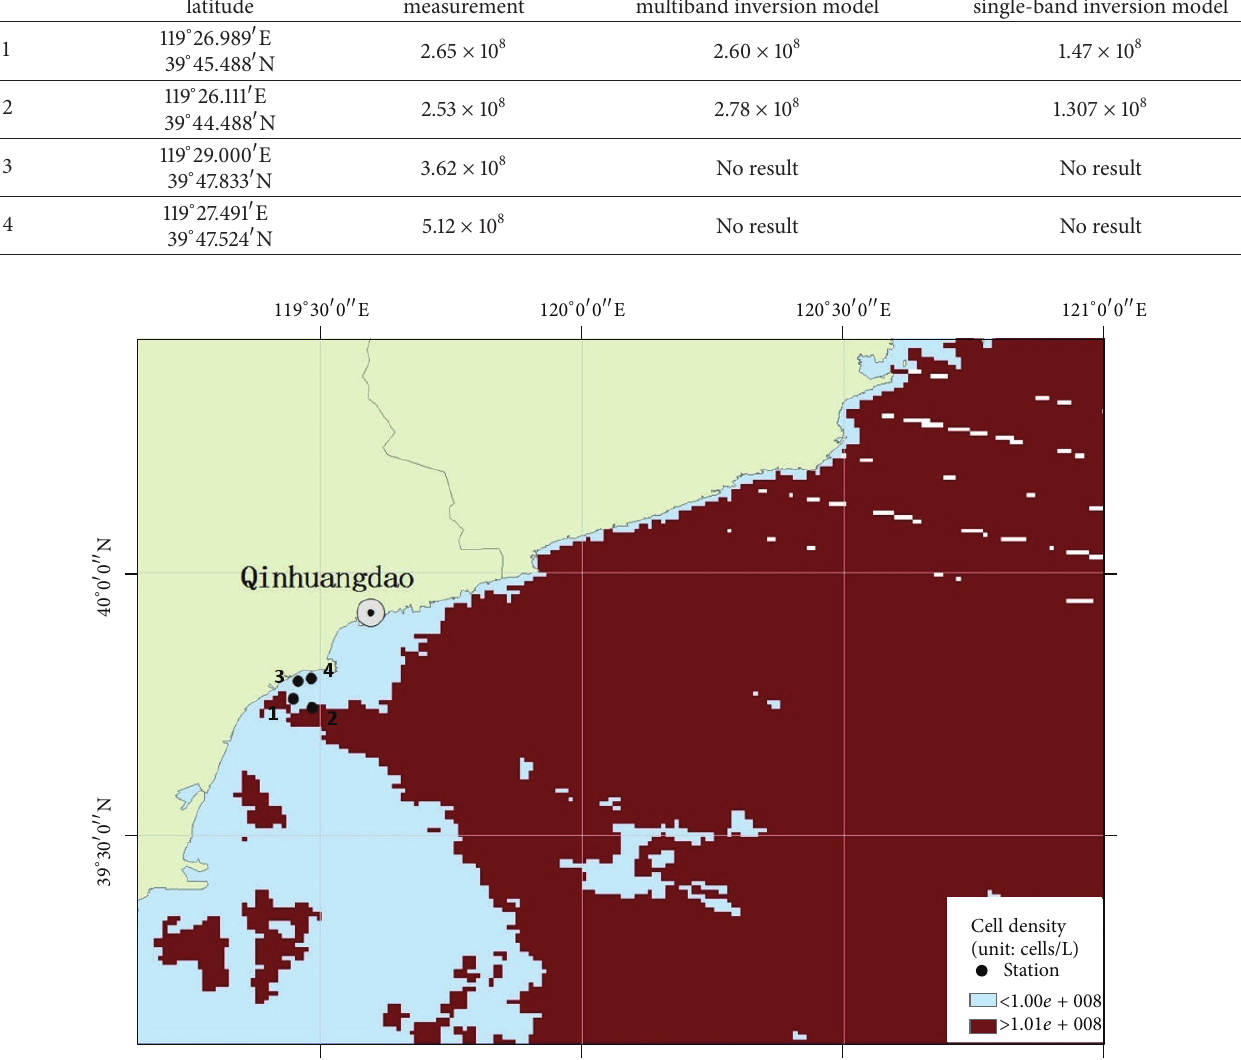
Figure 7: The distribution area of the Aureococcus anophagefferens red tide (multiband